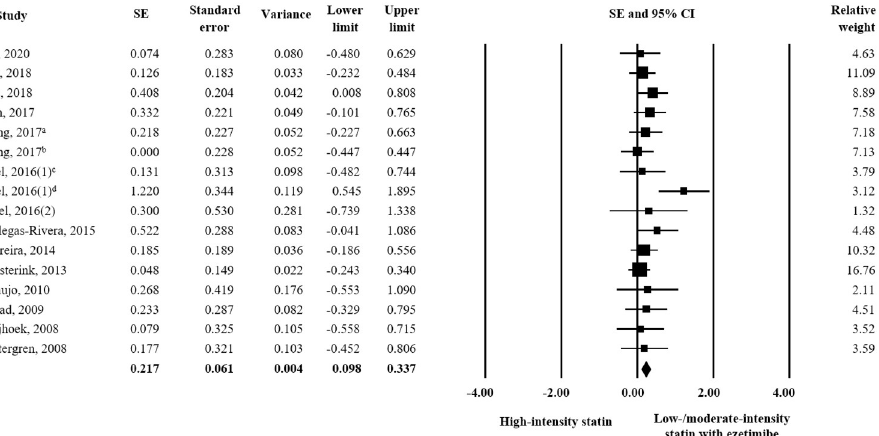
Fig 3. Forest plot of efficacy evaluation results. Changes in TC observed for high-intensity statin monotherapy and low/moderate-intensity statin plus ezetimibe combination therapy. a rosuvastatin 20 mg vs. rosuvastatin 5 mg plus ezetimibe 10 mg; b rosuvastatin 20 mg vs. rosuvastatin 10 mg plus ezetimibe 10 mg; c rosuvastatin 20 mg vs. atorvastatin 10 mg plus ezetimibe 10 mg; d atorvastatin 40 mg vs. atorvastatin 10 mg plus ezetimibe 10 mg.